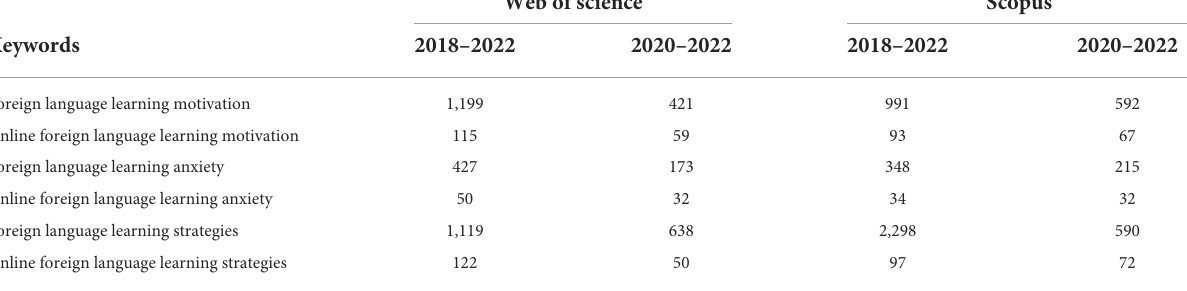
TABLE 1 Results of keyword search on Web of Science and Scopus